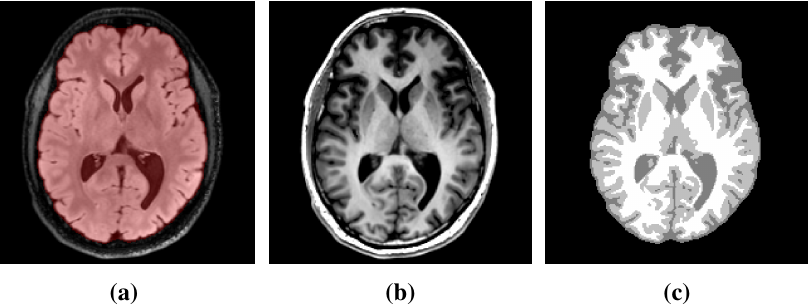
Figure 1. Example of processed MR data. ( a ) Axial slice of the T2 FLAIR image with superimposed segmented brain mask (red). ( b ) Corresponding slice of the T1 BRAVO image. ( c ) Segmented brain map obtained with the MICO algorithm [38] followed by manual